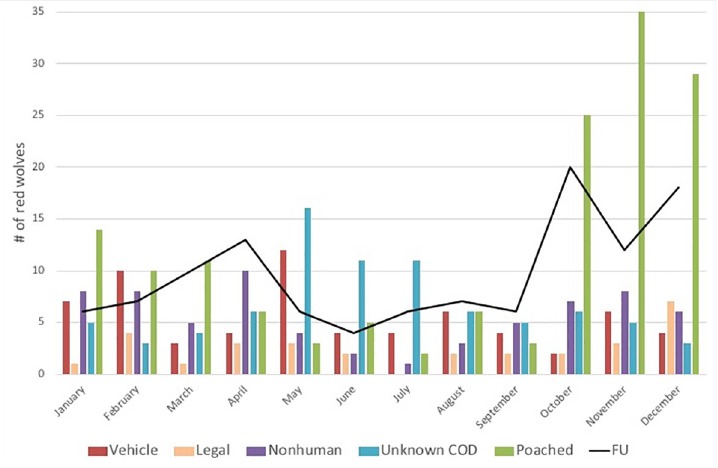
Fig 4. Red wolf mortality each month (bars) compared to fate unknown (FU, black line). FU are represented with a black line because there is more uncertainty with date of disappearance than with date of known deaths. Causes of death include legal, vehicle, poached, nonhuman, and unknown cause of death (COD) (Fig 4 in S1